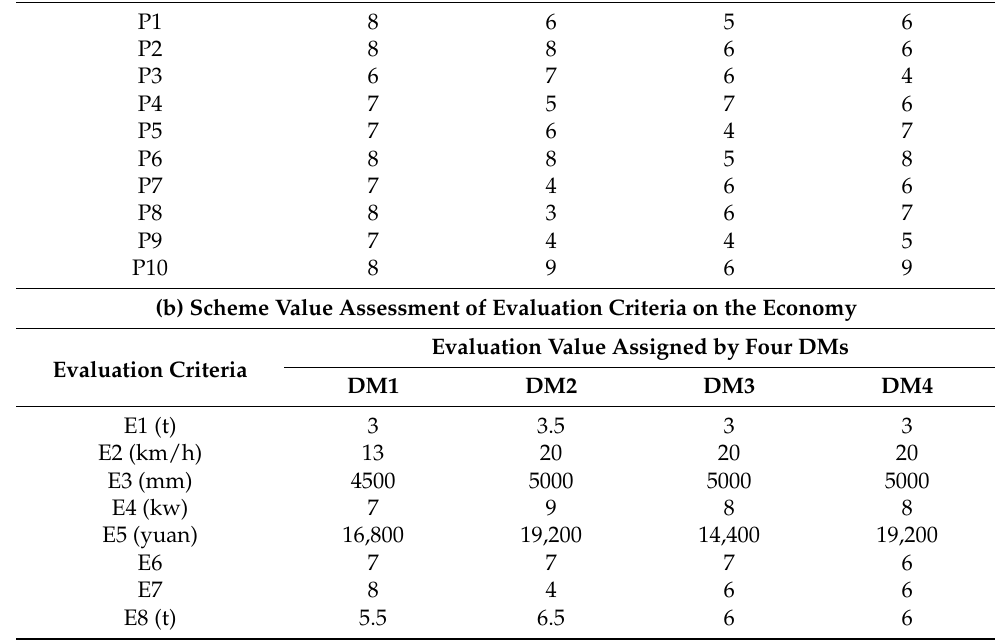
Table A5. Initial evaluation matrix of the electric forklift PSS concept (taking the CS5 as an example). (a) Scheme Value Assessment of Evaluation Criteria on the PSS Design Evaluation Criteria